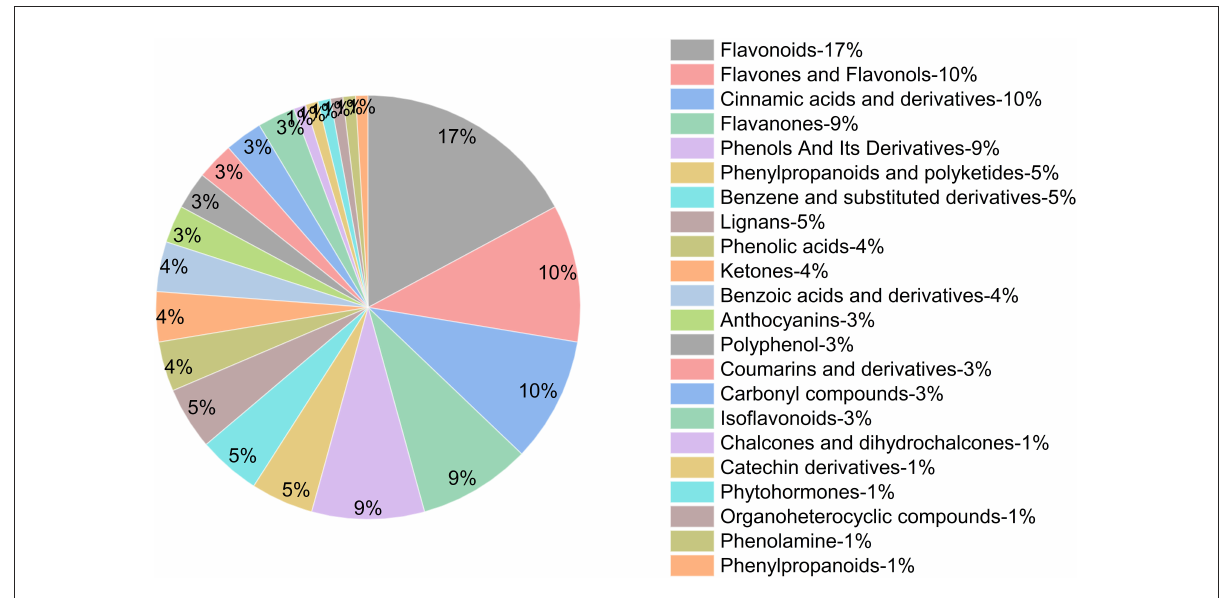
FIGURE8 Phenolic profiles in camellia